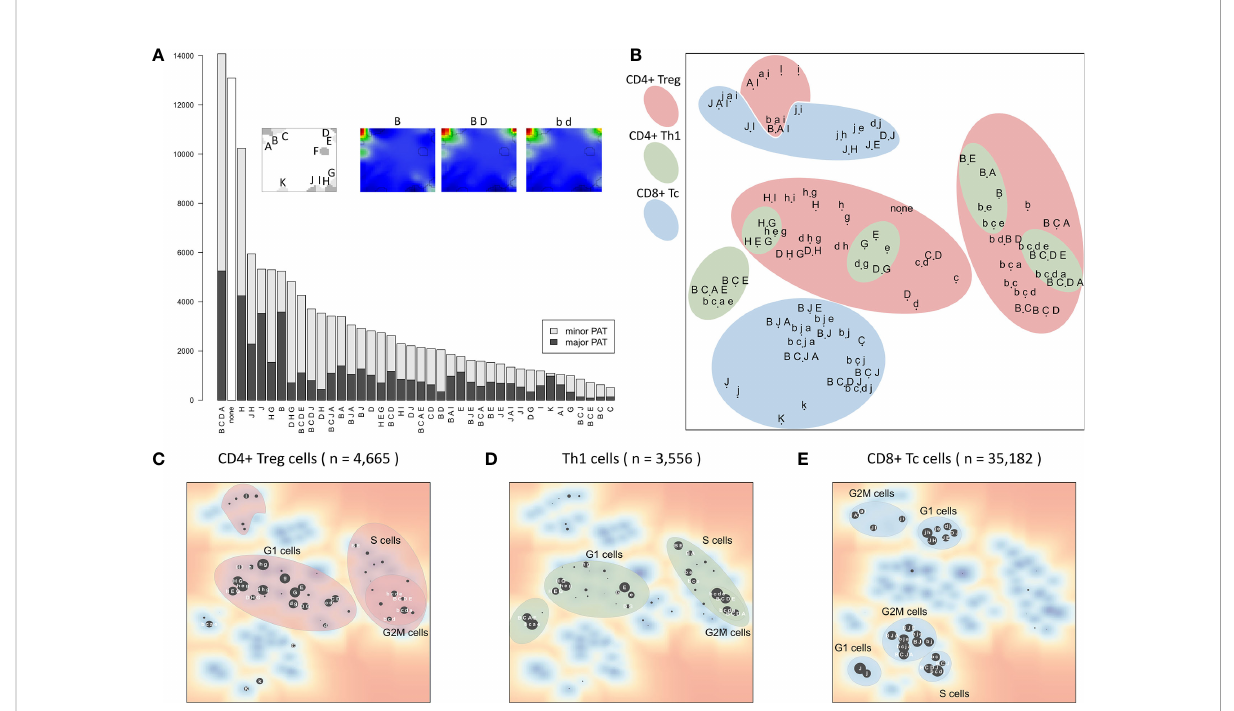
FIGURE 5 Module activation patterns (PATs) of activated expression modules reveal modular combinatorics: (A) Frequency of the module combinations detected in the cells. Major PATs collect samples with all modules exceeding the 1 s expression threshold, minor PATs those with all modules >0.5 s , but some <1 s (see also example portraits). (B) The PAT map is generated using t-SNE on PATs ’ average expression values. PATs enriched in the three major T cell subpopulations and cell cycle phases are highlighted (see panels (C – E) . Red and blue areas include cycling (B-type) and LAG3- exhausted (J-type) PATs, respectively. (C – E) t-SNE map of PATs enriched in all CD4+ Treg, Th1 and CD8+ Tc, respectively. Size of the dots scales with enrichment ( – log10 p-value in Fisher ’ s exact test, data is given as Supplementary File